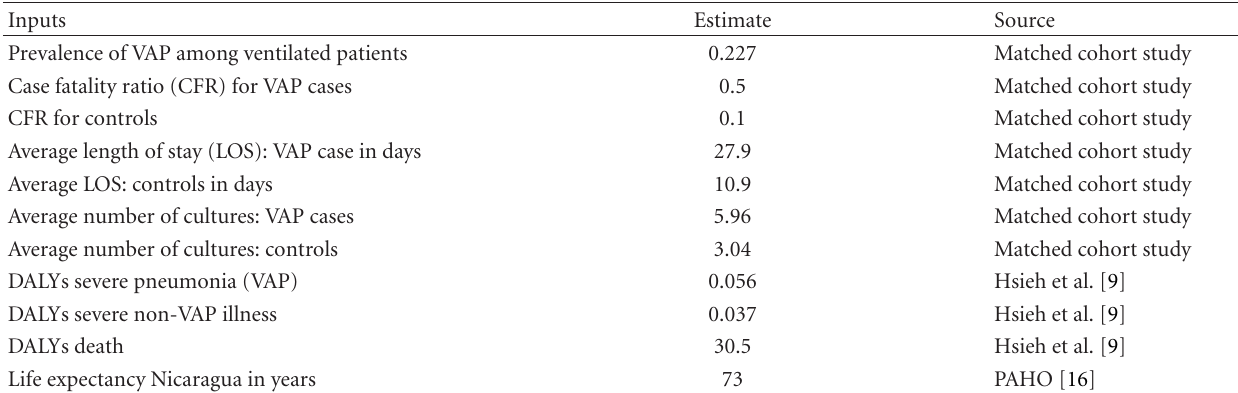
Table 2: Noncost inputs for cost e ff ectiveness analysis model.